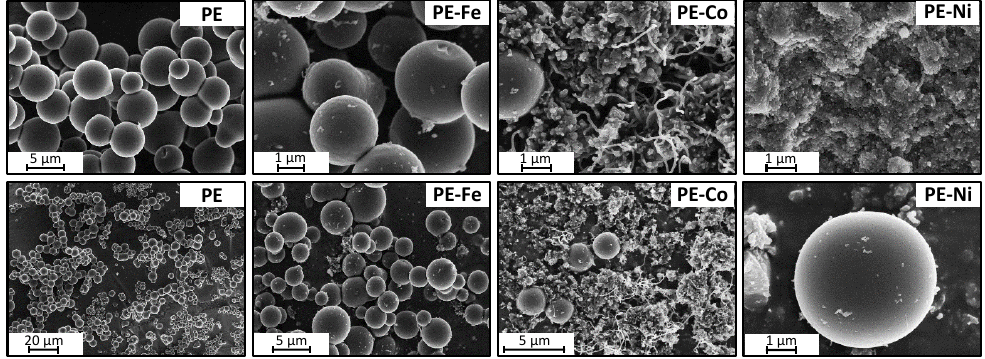
Figure 2. SEM images of carbon spheres nanocomposites at different magnifications.